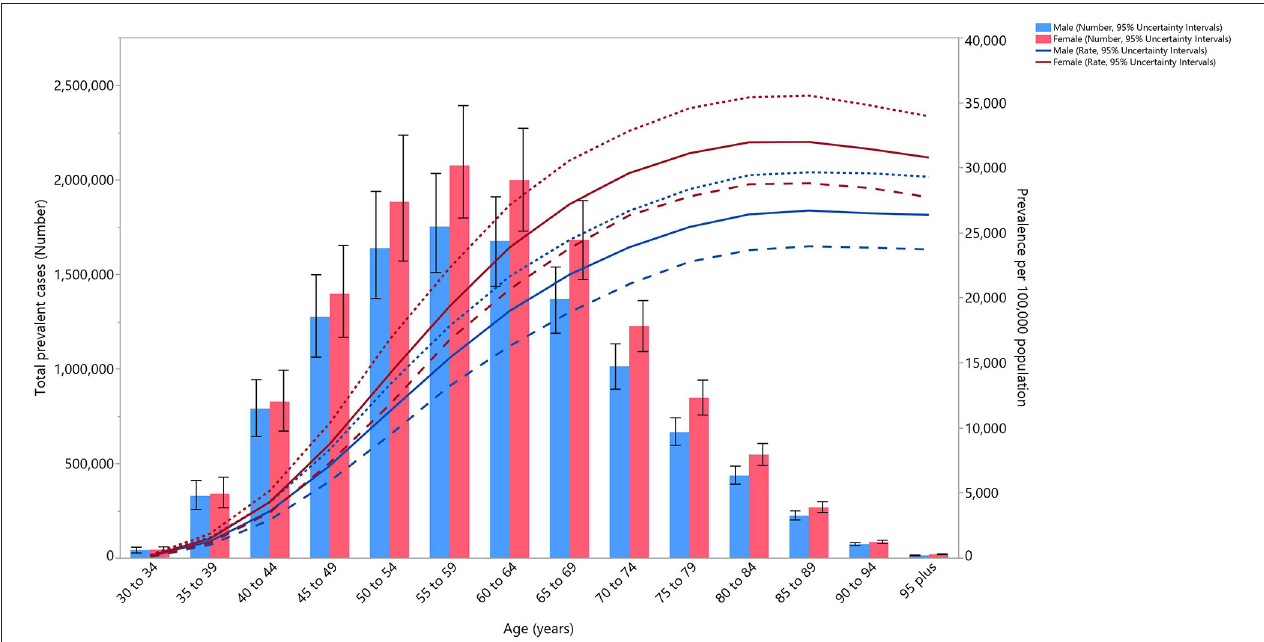
FIGURE 1 | Numbers of prevalent cases and prevalence of osteoarthritis per 100,000 population in the Middle East and North Africa region, by age and sex in 2019. Dotted and dashed lines indicate 95% upper and lower uncertainty intervals, respectively (generated from data available from http://ghdx.healthdata.org/gbd-results- tool).